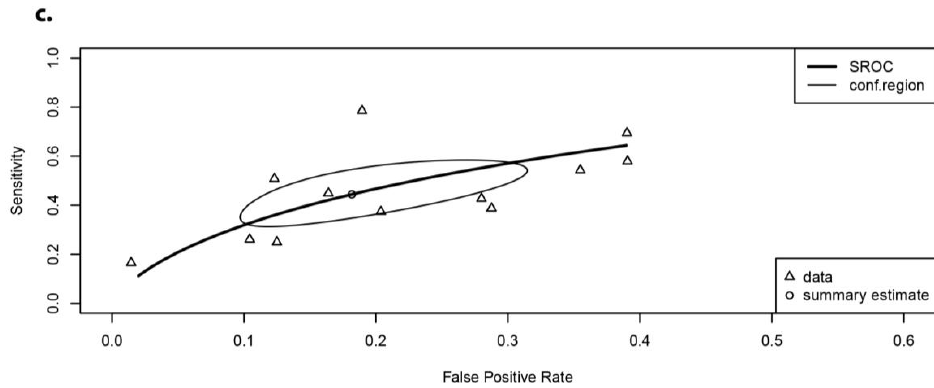
Figure 2. Sensitivity forest plot, specificity forest plot, and summary receiving operating characteristic (SROC) plot for pain during urination question ( S. haematobium ): ( a ) sensitivity forest plot; ( b ) specificity forest plot; and ( c ) SROC curve with summary sensitivity and false positive rate (1-specificity) (circle) and the 95% confidence region (ellipse). Each triangle represents the summary sensitivity and false positive rates from one study.